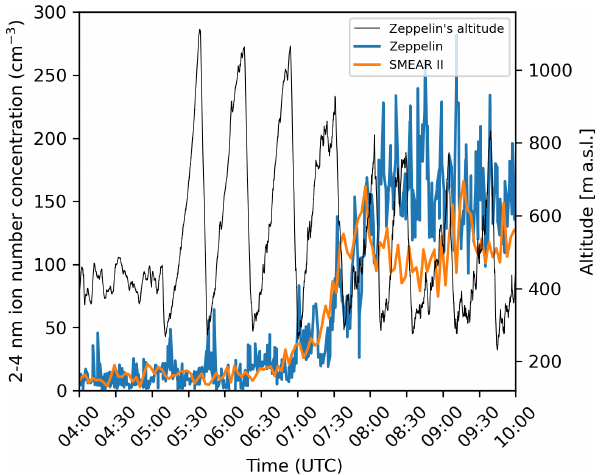
Figure 5. Time series of intermediate (2–4nm) ion number concen- tration on board the Zeppelin and the SMEAR II station and the Zeppelin’s altitude in HTL on 8 May 2013.